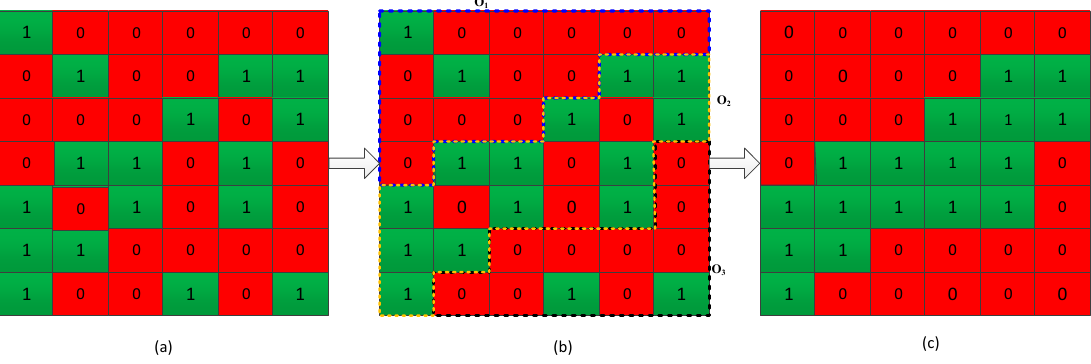
Figure 2. Schematic example of using OBEM to refine a raw binary change detection map: ( a ) Raw Binary Change Detection Map (R_BCDM); ( b ) Overlay multi-scale segmentation over R_BCDM; ( c ) OBEM postprocessing to generate Final Binary Change Detection Map (F_BCDM).